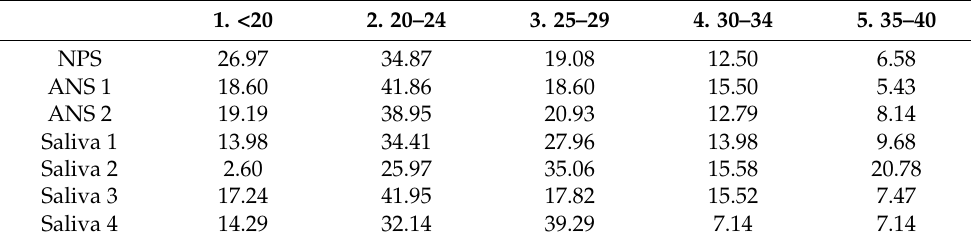
Table 3. Percentages of samples falling into respective C t categories for individual tests.